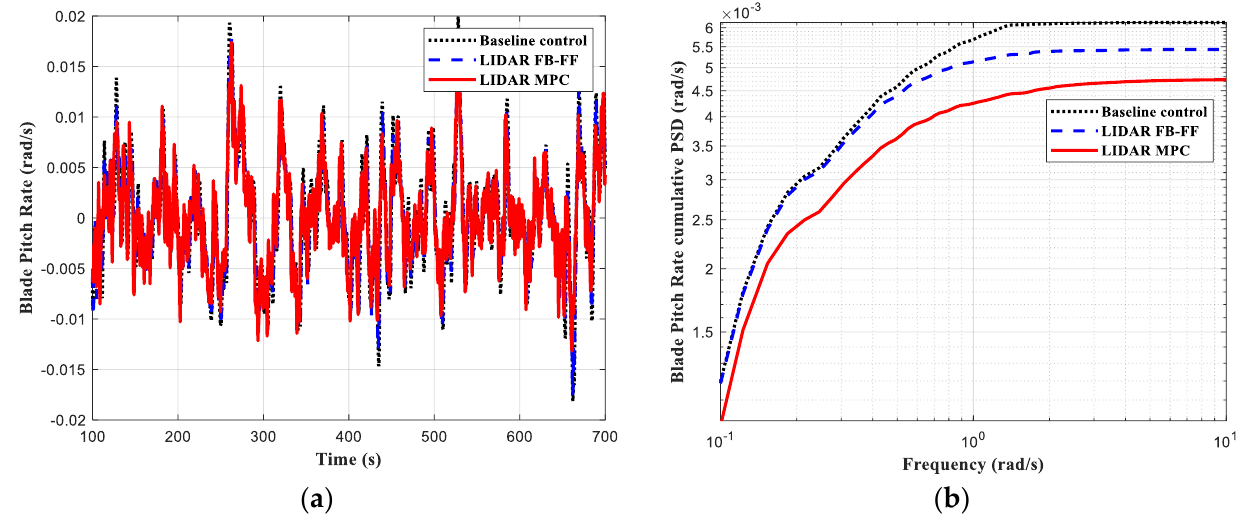
Figure 15. Blade pitch rate: ( a ) time profiles; ( b ) cumulative PSD (wind speed with 15% turbulence intensity). Table 5. Performance statistics for a wind speed with 15% turbulence intensity.